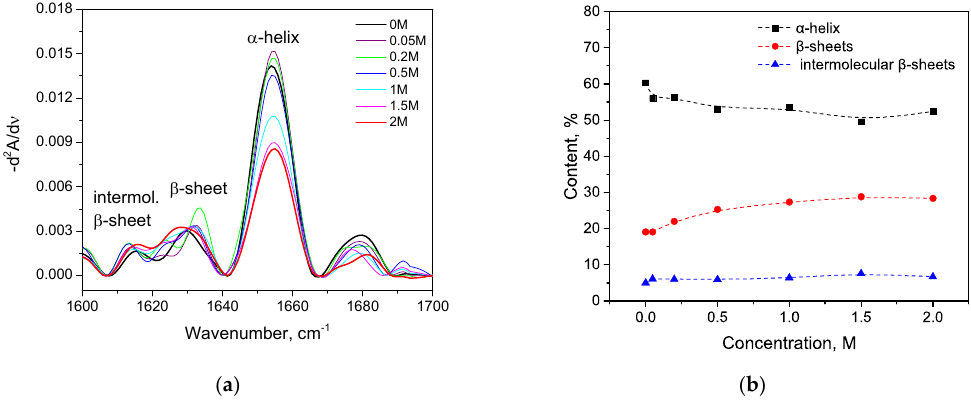
Figure 6. Changes in the second derivative of the Amide I band ( a ) and in secondary structure ( b ) of HSA in 10% wt. aqueous solution at 23 °C with various concentrations of KCl.